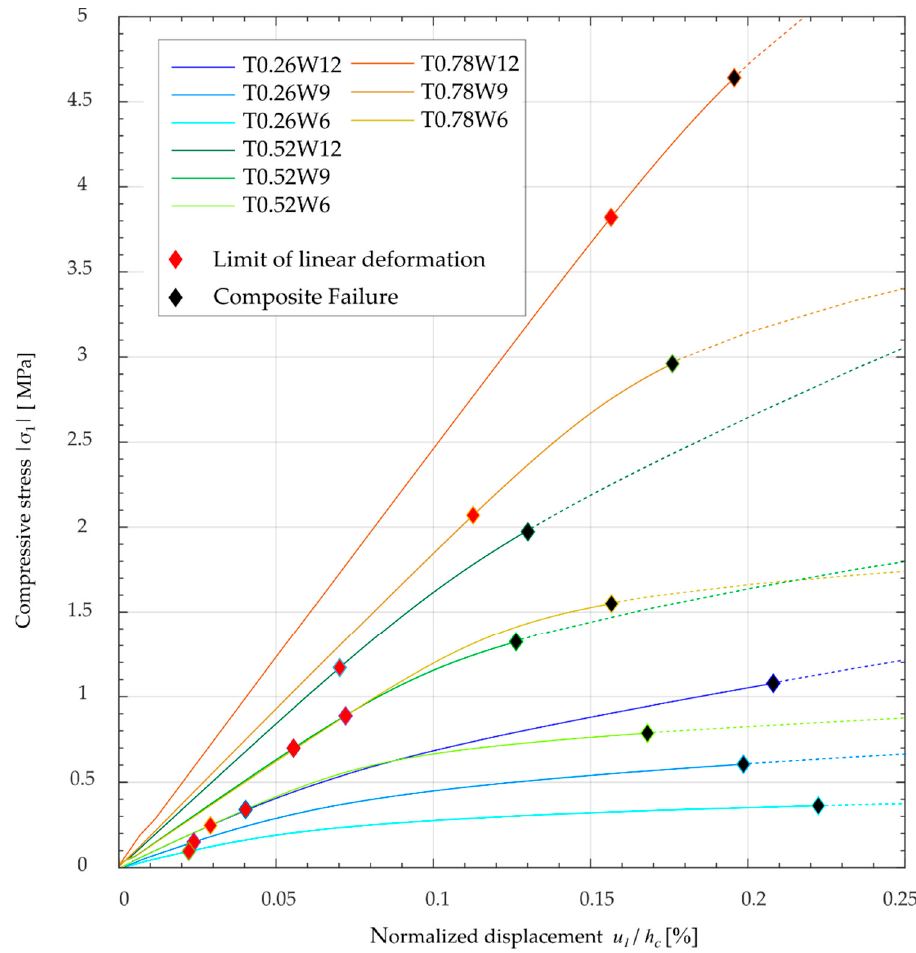
Figure 4. Stress-strain curves of the tape configurations with theoretical structural response. The failure of the structure, represented by black markers, occurs at a displacement range of 0.13% to 0.22% of the core height. This corresponds to a deformation in x 1 -direction of 0.39 mm and 0.66 mm, respectively. Compressive strengths of the core of 0.36 MPa to 4.6 MPa are achieved. The red marks represent the point where the deviation from the